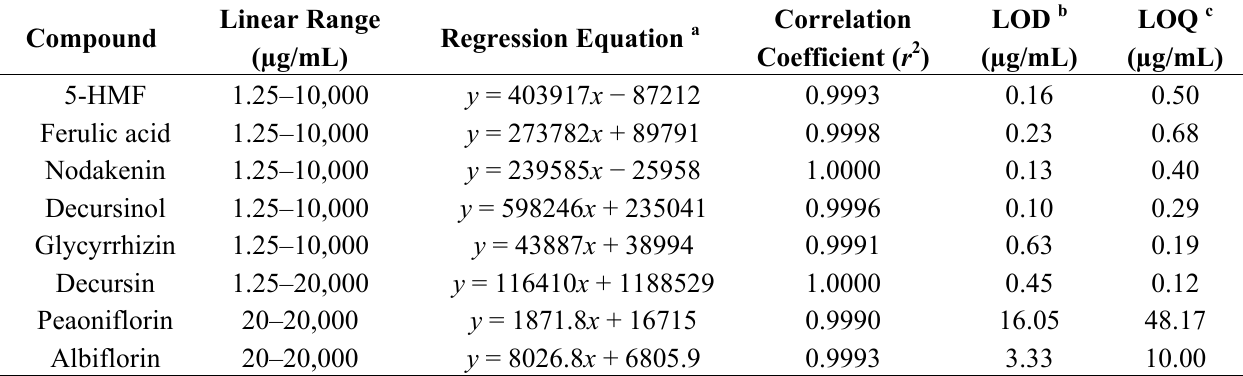
Table 1. Linearity, correlation coefficient, limits of detection (LOD), and limits of quantification (LOQ) of the marker compound ( n = 3).